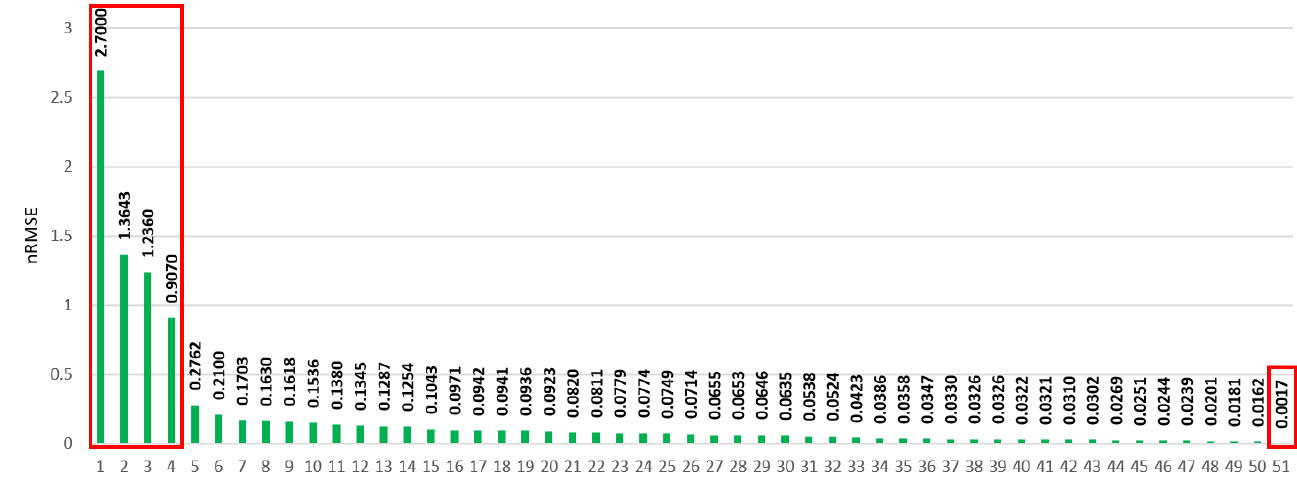
Figure 22. Variability of nRMSEs in the reviewed papers, with red-marked less reliable values.